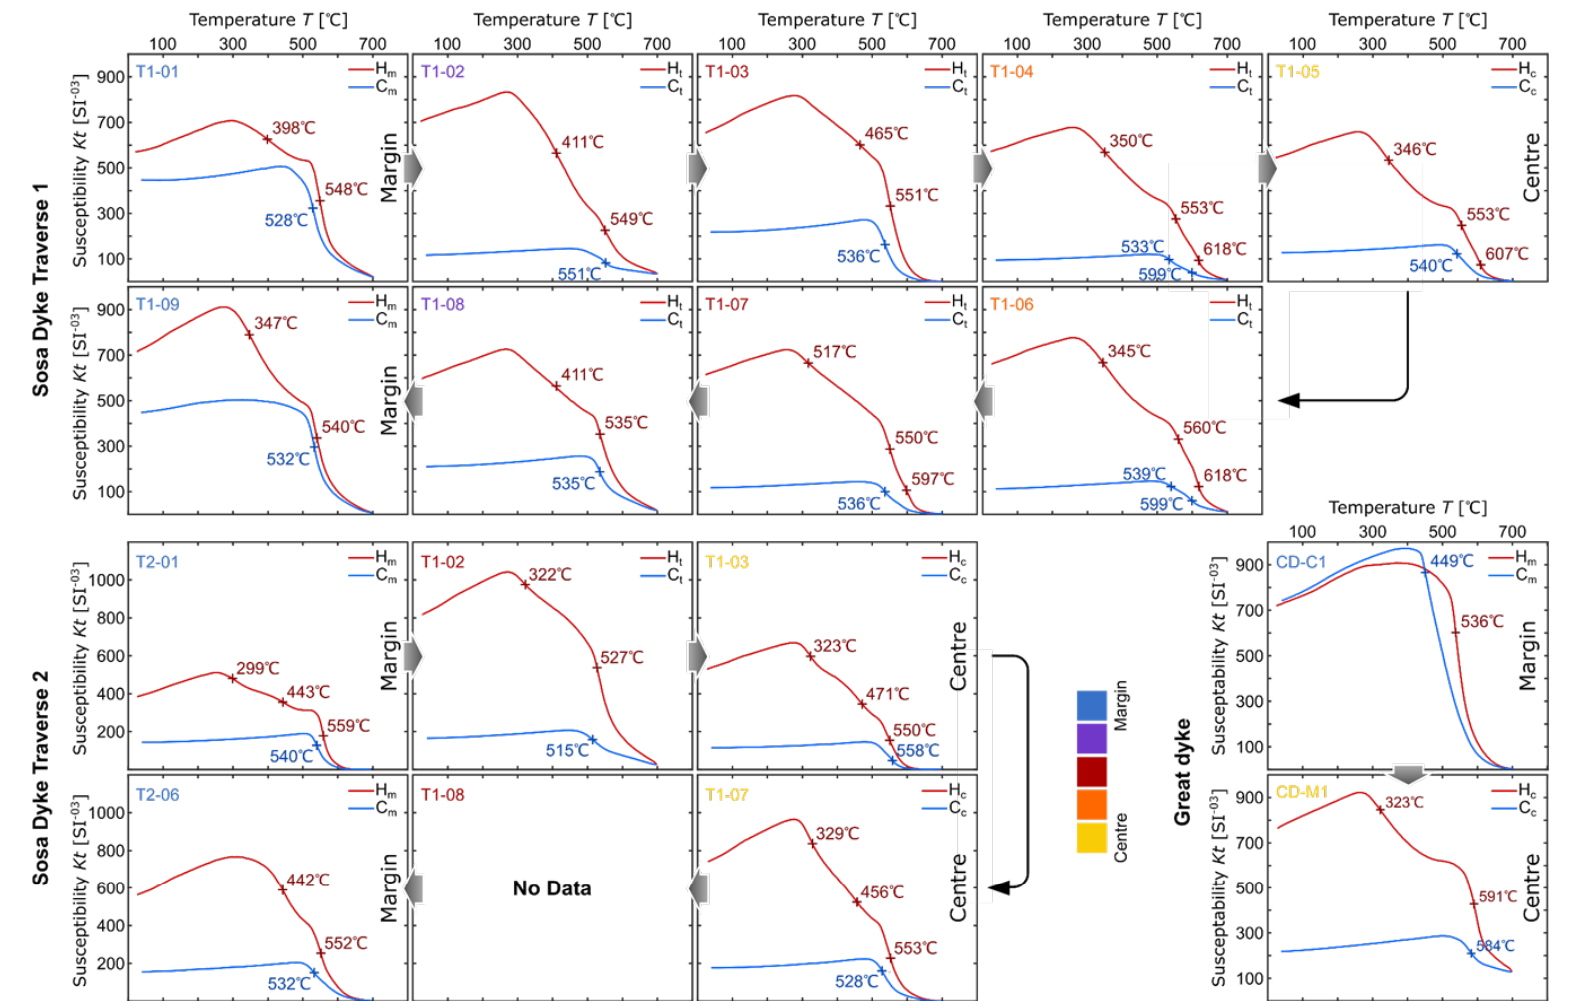
Figure A3. Temperature depended magnetic susceptibility. Each plot shows a heating (red line) and cooling (blue line) curve of a sample from T1 and T2 of the Sosa Dyke and a margin and centre sample of the Great Dyke. Temperature values indicate local extrema of the first derivative.